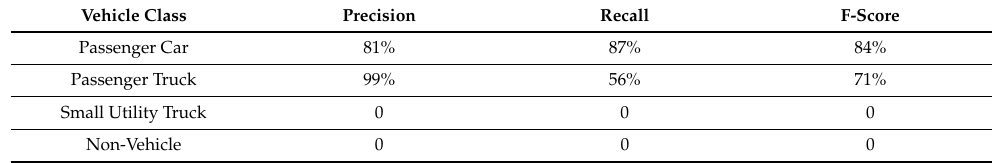
Table 13. Different evaluation metrics for detected vehicles in multiple vehicle clusters within Video 2.